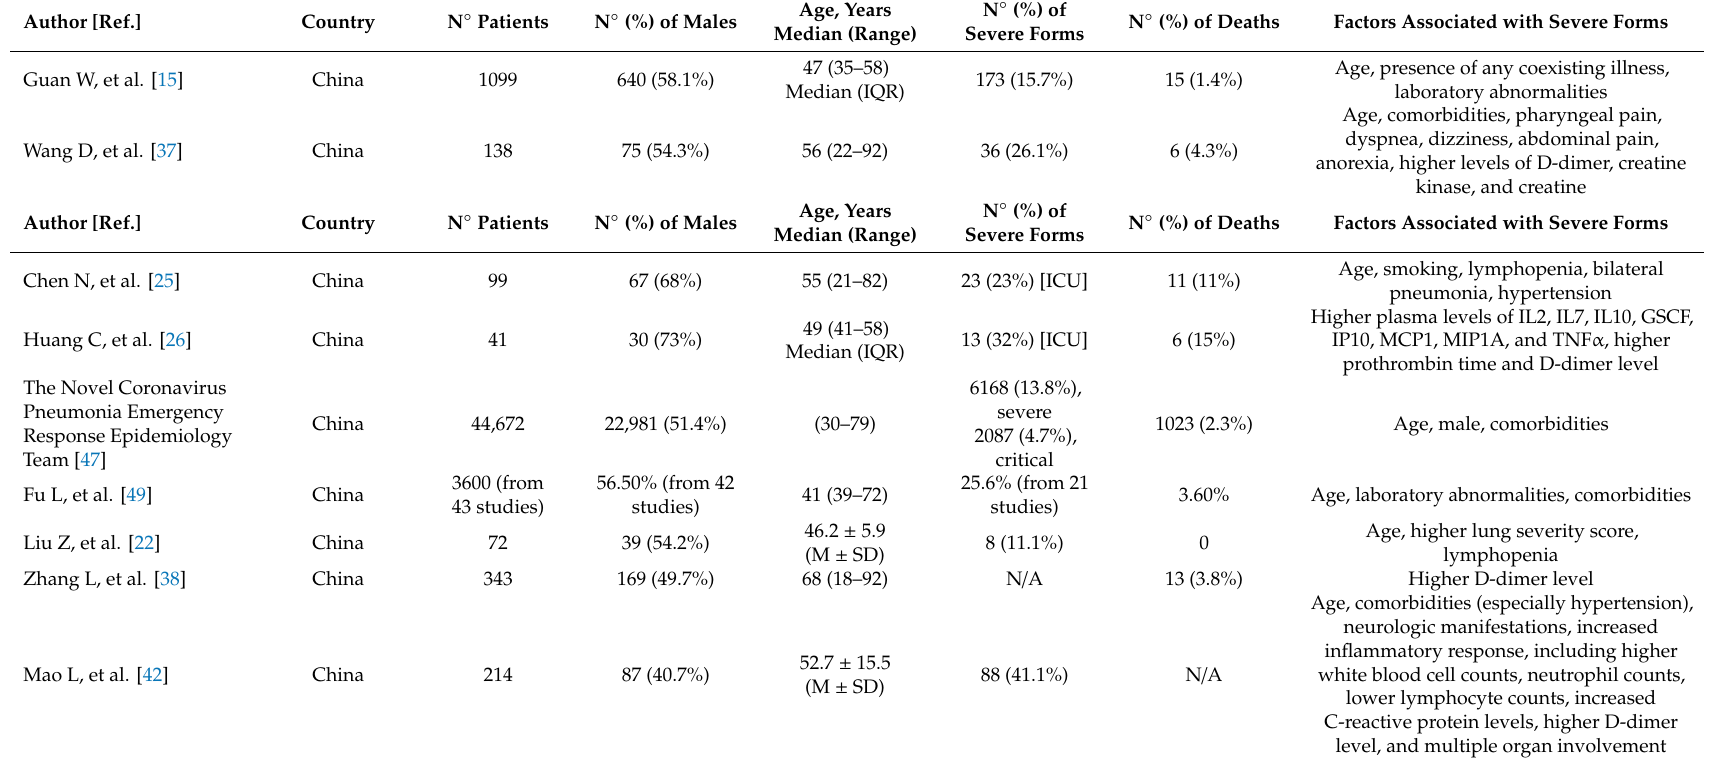
Table 3. Studies evaluating the severe clinical forms of